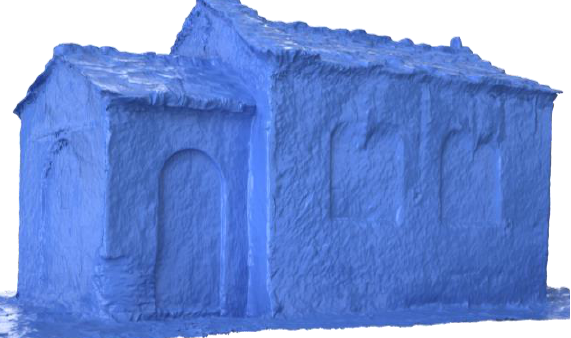
Figure 18. S. Maria Chapel 3D model (Arch. Alessio